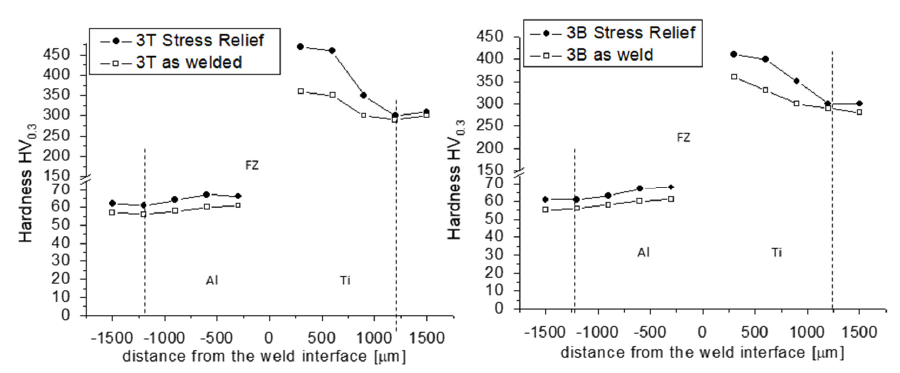
Table 3. Average results coming from tensile test of two specimens for joints 1T, 1B, 3T, 3B.